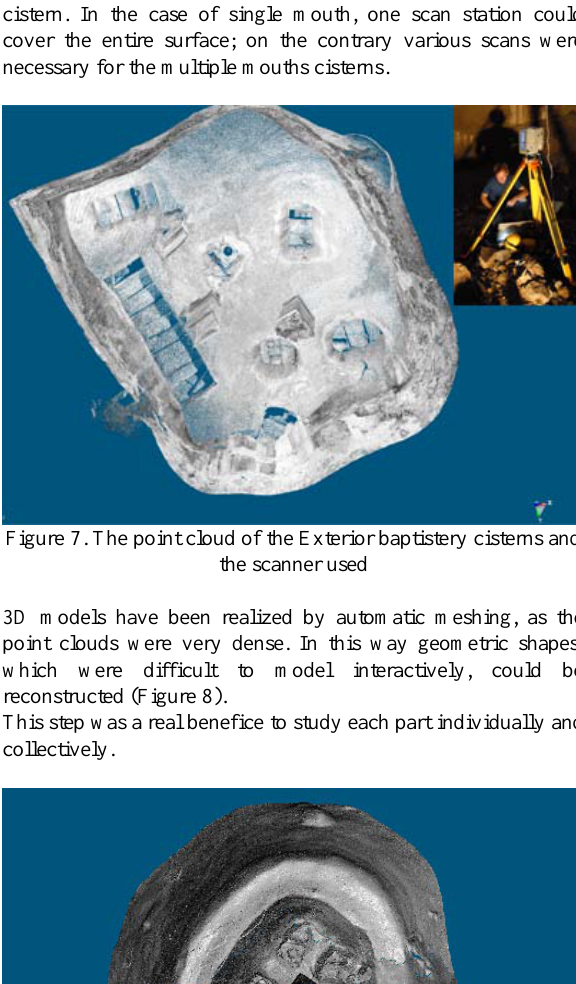
Figure 4. The geometric reconstruction